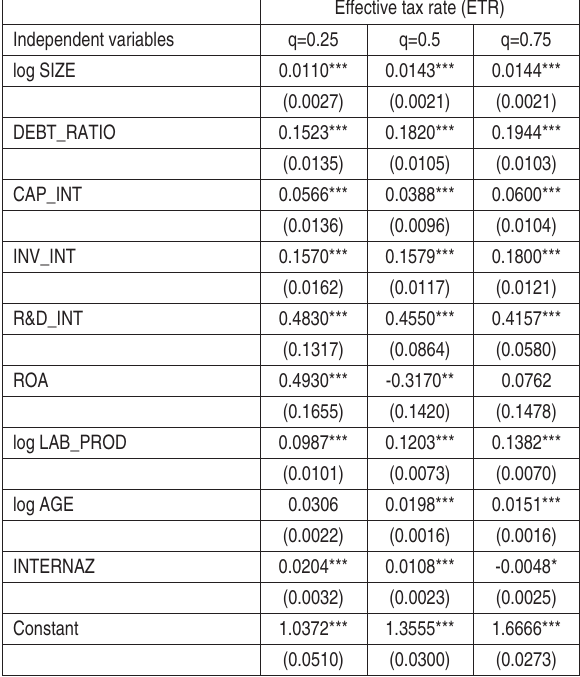
Table 5. Quantile regression